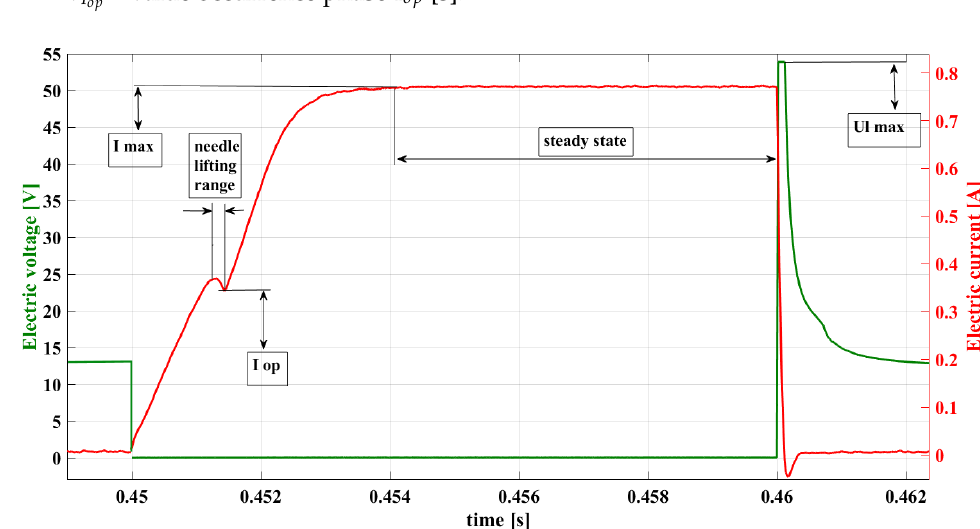
Figure 1. Characteristic points of a sample current waveform.